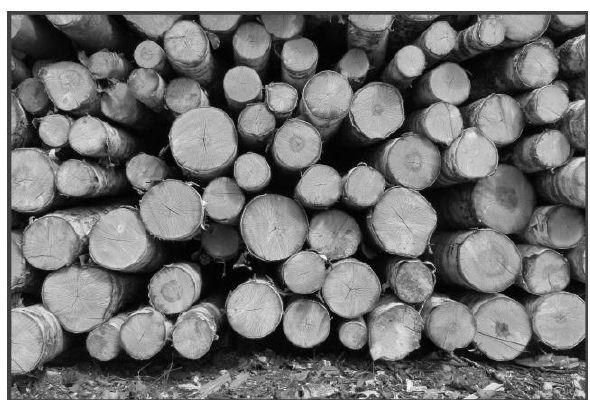
Figure 4. The orthophoto of the controlled stack part Figure 4 presents the orthophoto of a stack produced basing on the reference plane and left image. In the orthophoto lens distortion and projection distortion are compensated using results of calibration and supposition about reference